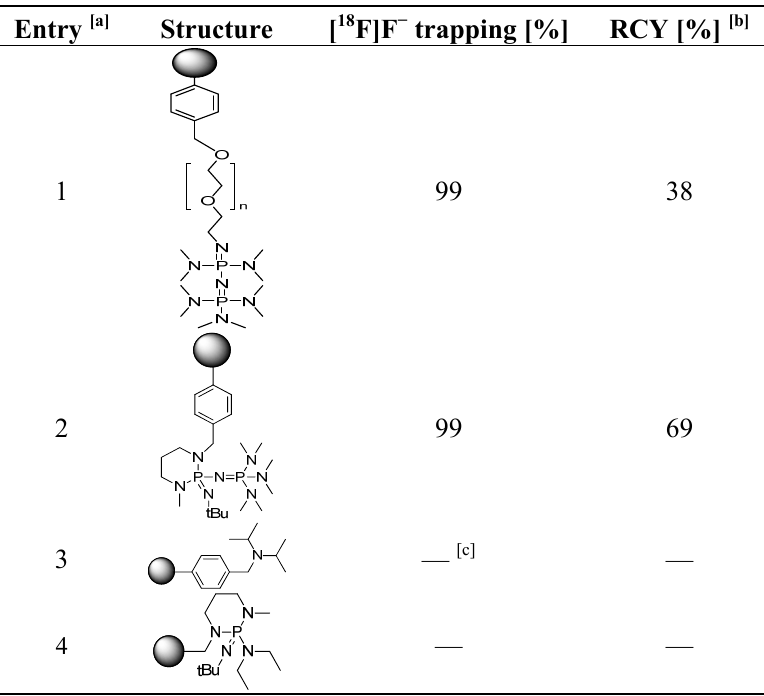
) OMs: the scope of the polymer supported 2 2